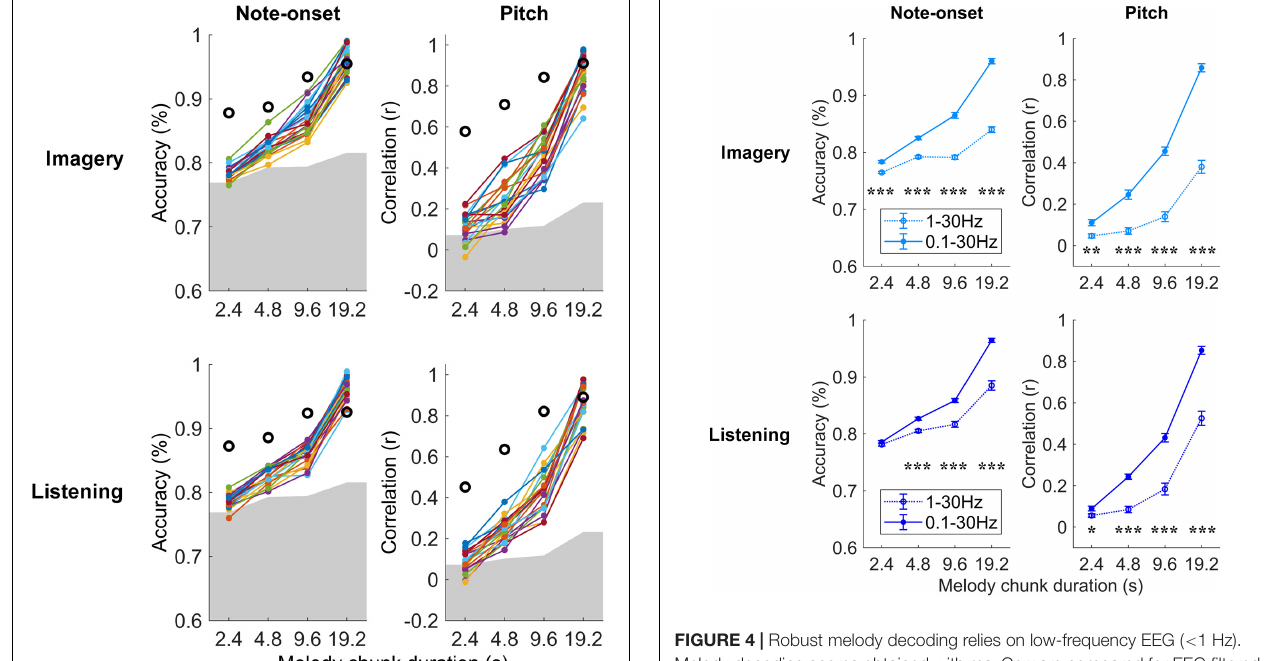
FIGURE 4 | Robust melody decoding relies on low-frequency EEG ( < 1 Hz). Melody decoding scores obtained with maxCorr are compared for EEG filtered in the bands 0.1–30 Hz and 1–30 Hz. The inclusion of the low frequencies between 0.1 and 1 Hz largely increases the decoding scores in the imagery and listening conditions (three-way repeated measures ANOVA p < 0.05, post hoc Tukey’s HSD; * p < 0.05, ** p < 0.01, *** p < 0.001).